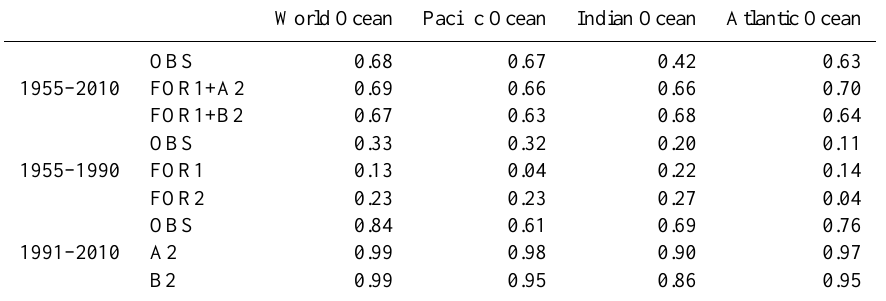
Table 1. Coefficients of determination R 2 between the OHC700 and the total equivalent radiative forcing during the periods 1955–2010, 1955–1990 and 1991–2010. In this particular case, the R 2 coefficient represents the fraction of OHC700 variance explained by the forcing, and is calculated for the whole ocean and also individually for the three major basins. Values exceeding the 95% confidence level according to a Student’s t test that takes into account the series autocorrelation to correct the sample size are highlighted in bold.